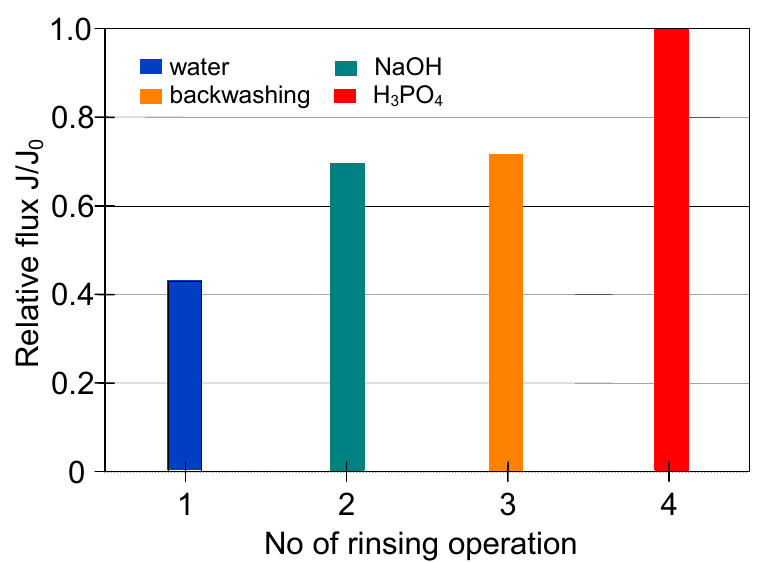
Figure 13. The efficiency of cleaning the ceramic membrane after the MF of 1,3-PD fermentation broth with Citrobacter freundii (V F = 11 m/s. TMP = 0.08 MPa). Operation time: water—30 min, NaOH—25 min, backwash—25 min, acid—50 min.